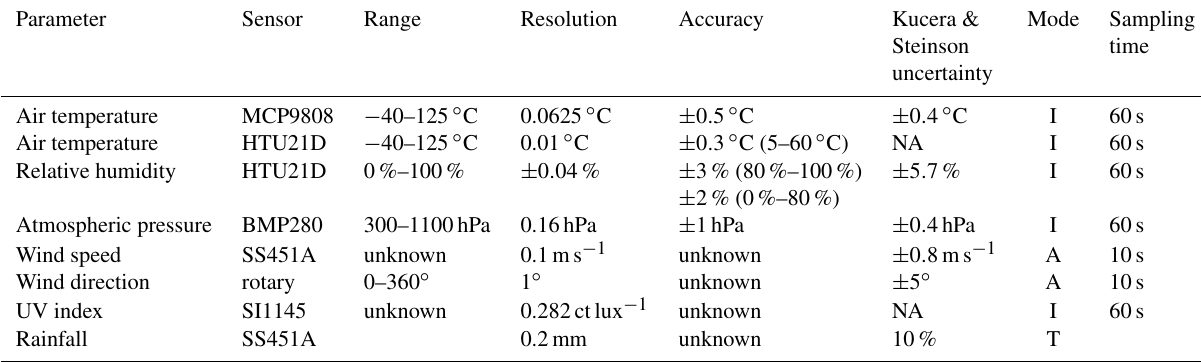
Table 1. 3D weather station sensor